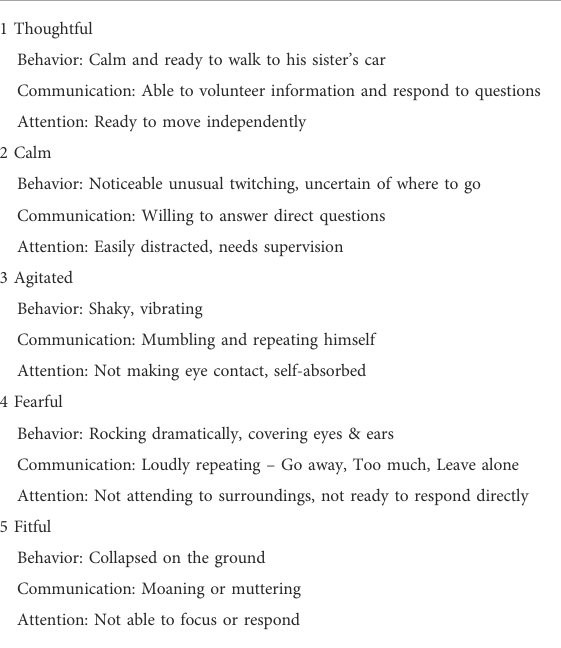
TABLE 3 Levels of behavior for